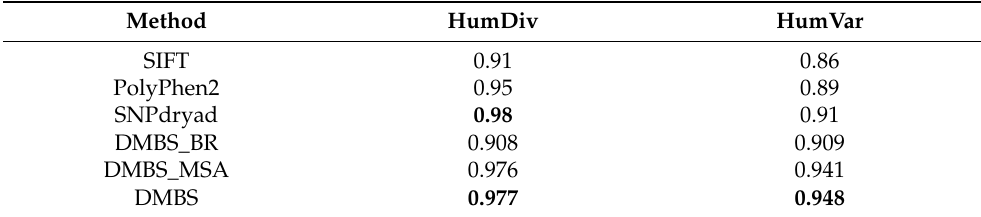
Table 2. AUCs for DMBS, two the DMBS variants (DMBS_BR and DMBS_MSA), and three current predictors of deleterious nsSNPs on the HumDiv and HumVar benchmark datasets. The AUCs were calculated based on the 10-fold cross validation. The highest AUC values for each dataset are highlighted in bold font. Summary of the benchmark datasets used in this work.